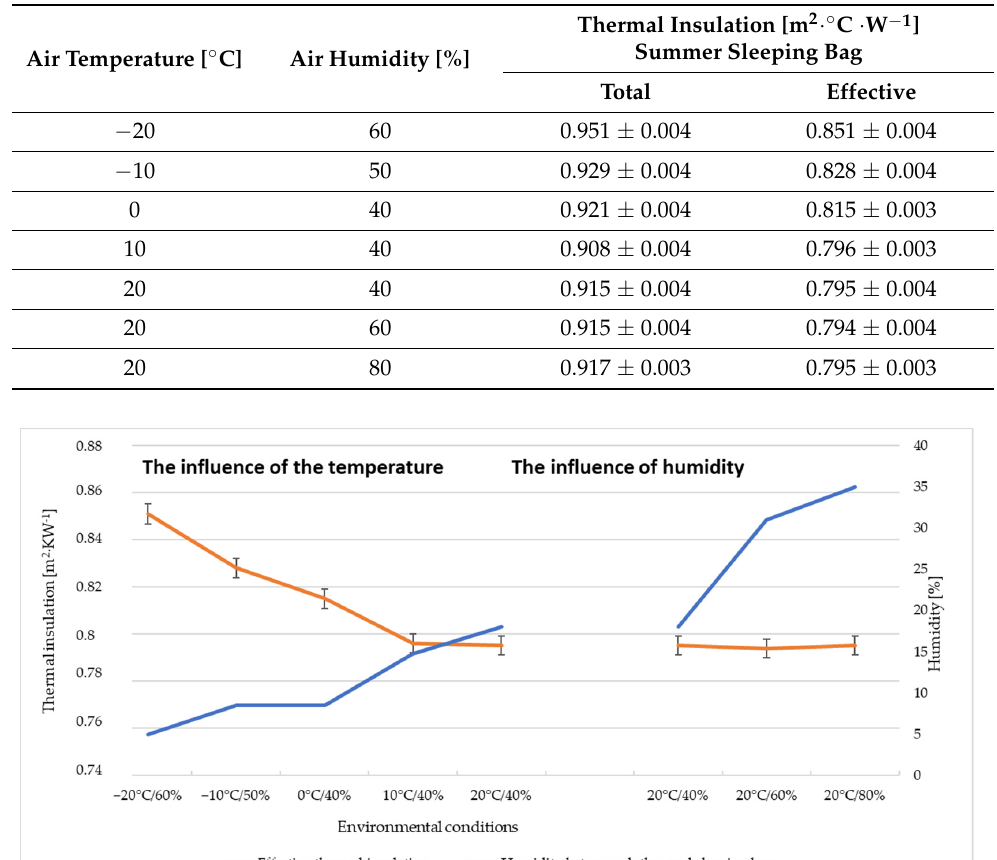
Table 6. Average thermal insulation of a mannequin in a summer sleeping bag.